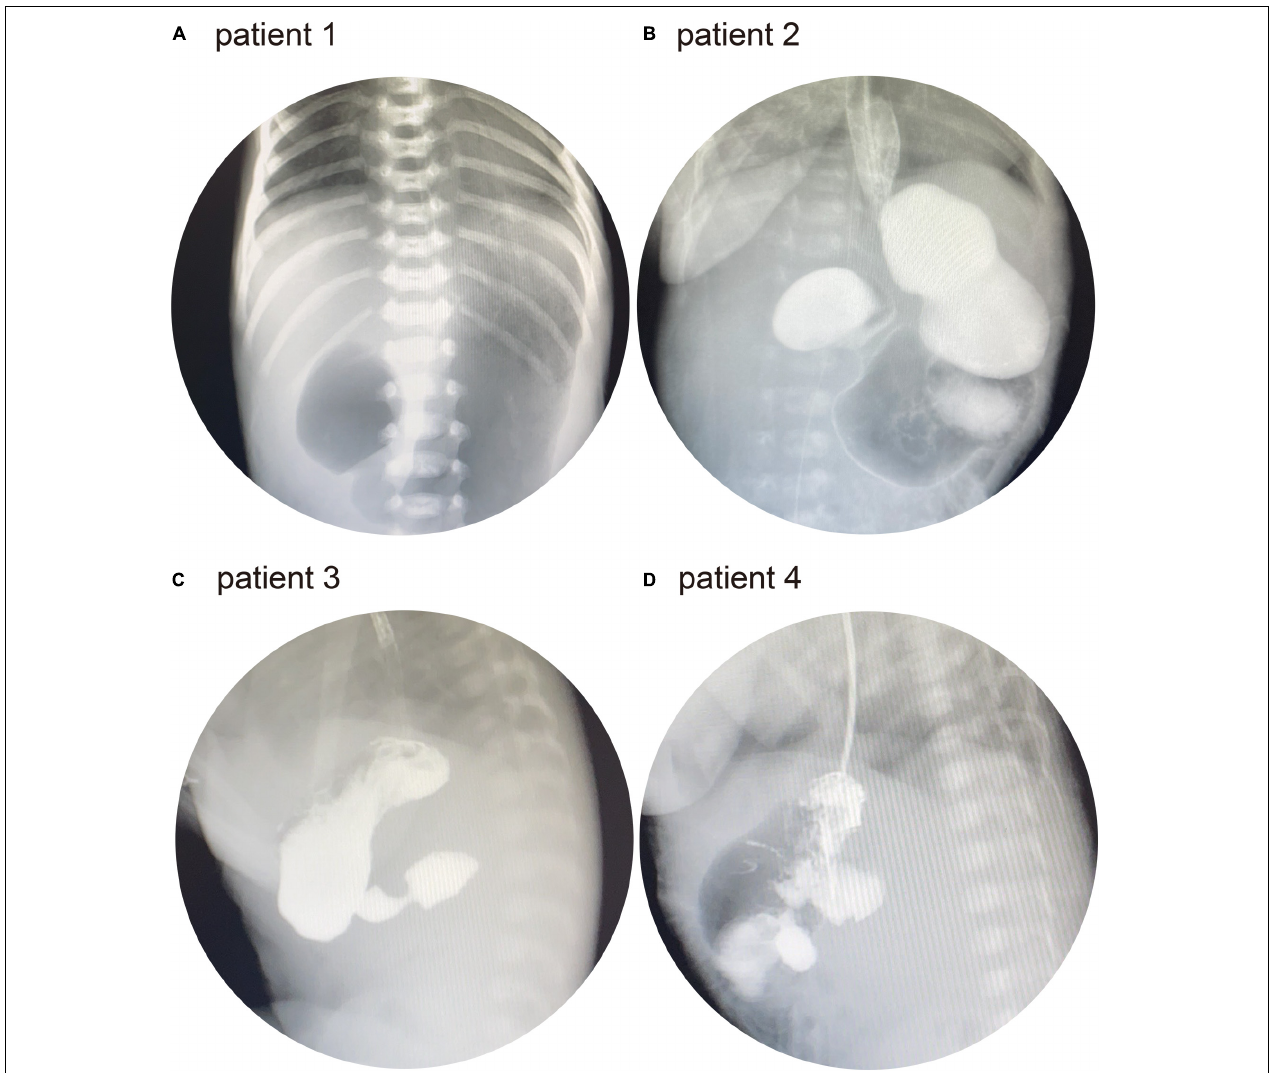
FIGURE 2 | (A) Patient 1: abdominal X-ray showed the “double bubble” sign. (B) Patient 2: upper gastrointestinal series (UGI) showed distended stomach and duodenal bulb. (C) Patient 3: UGI showed a distended duodenal bulb. (D) Patient 4: UGI showed a distended duodenal